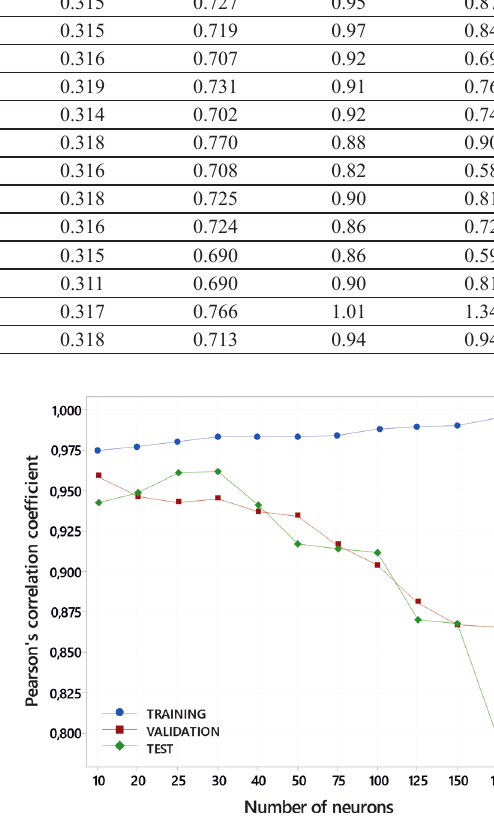
Figure 7. Model validation in training, validation and test.